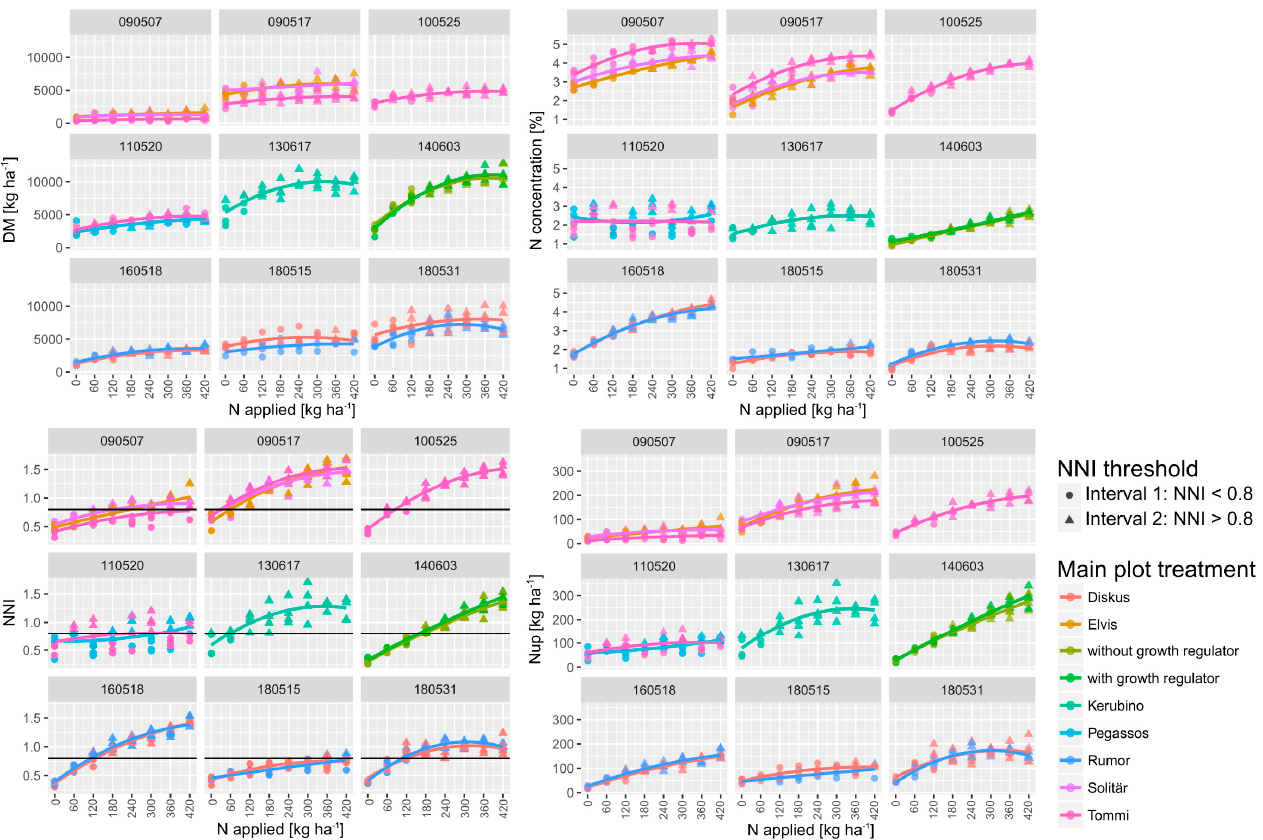
Figure 1. Quadratic response of reference traits to incremental N fertilization (N levels) by sampling dates (year / month / day) and main plot treatments. Nitrogen was applied incrementally increasing by 60 kg ha − 1 from 0–420 kg N ha − 1 in three doses (Table 1). For nitrogen nutrition index (NNI), the threshold used (NNI </> 0.8) for dividing the data into two intervals is drawn as a horizontal line. Interval 1 (NNI < 0.8) and interval 2 (NNI > 0.8) are indicated as circles and rectangles, respectively. See Supplementary Figure S1 for the N-response of the index R760_730.